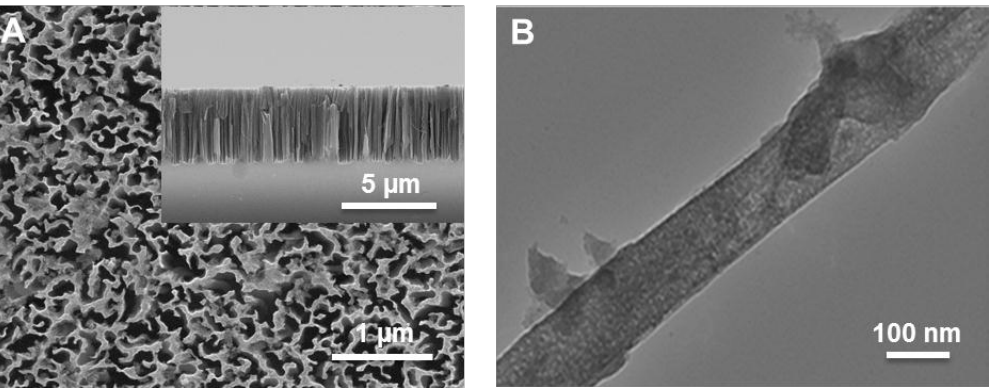
Figure 1. ( A ) Scanning electron microscopy (SEM) image of the fabricated silicon nanowires